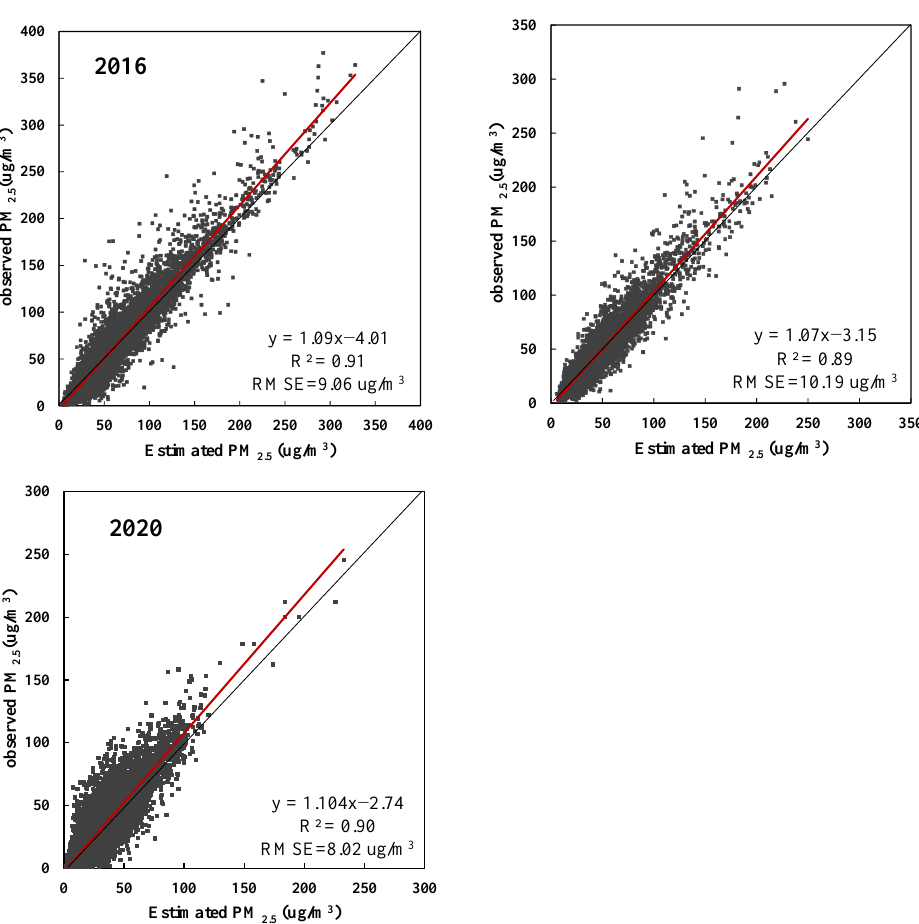
Figure 4. The 10-fold CV validation result of RF model. The red line defines the model-fitting line.